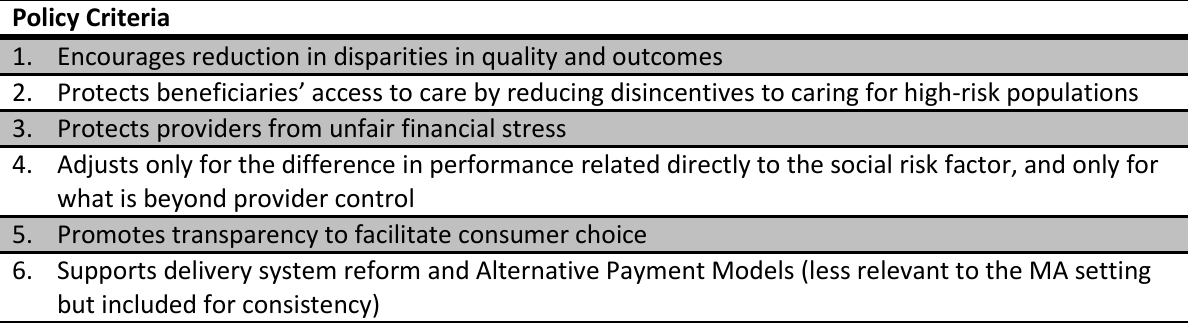
Table 8.7: Policy Criteria Policy